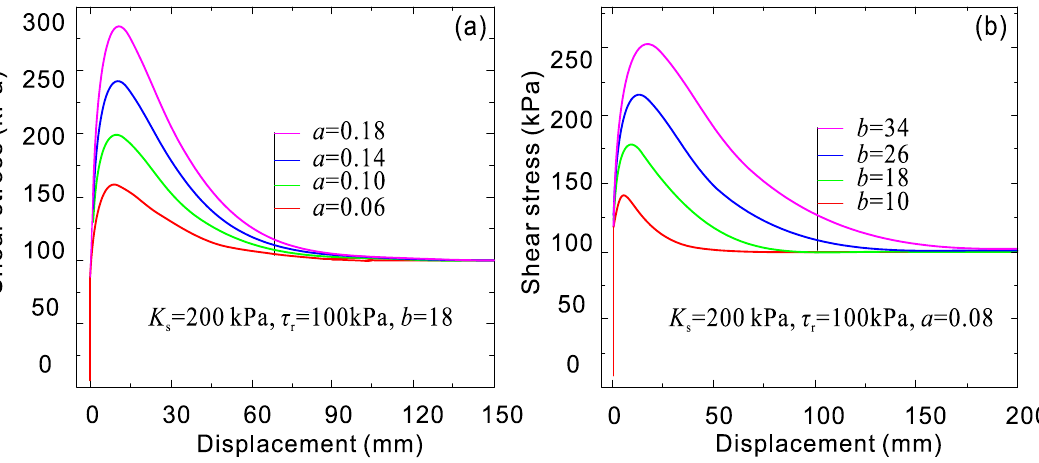
Figure 14. Effect of parameters of Gamma distribution on the shear curves. ( a ) model curves under various a values; ( b ) model curves under various b values.